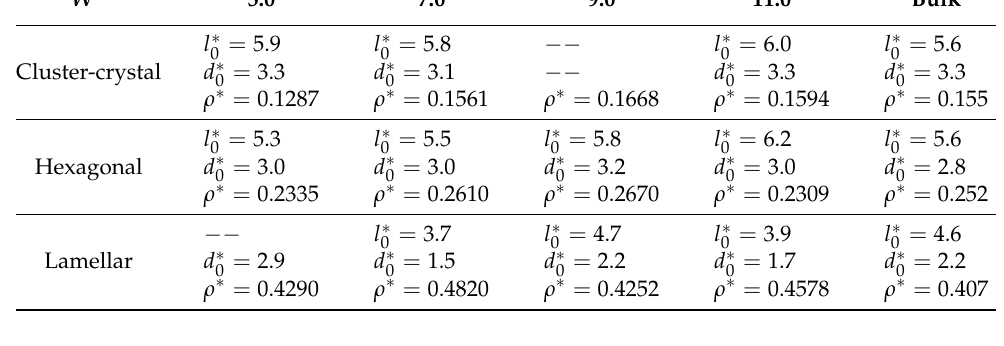
Table 2. Estimation of the distance between clusters ( l ∗ = d ( d ∗ 0 / σ ) in bulk and in the confined systems. The cluster size d 0 diameter in spherical and cylindrical clusters, and to the width of the lamellae in the lamellar phase.